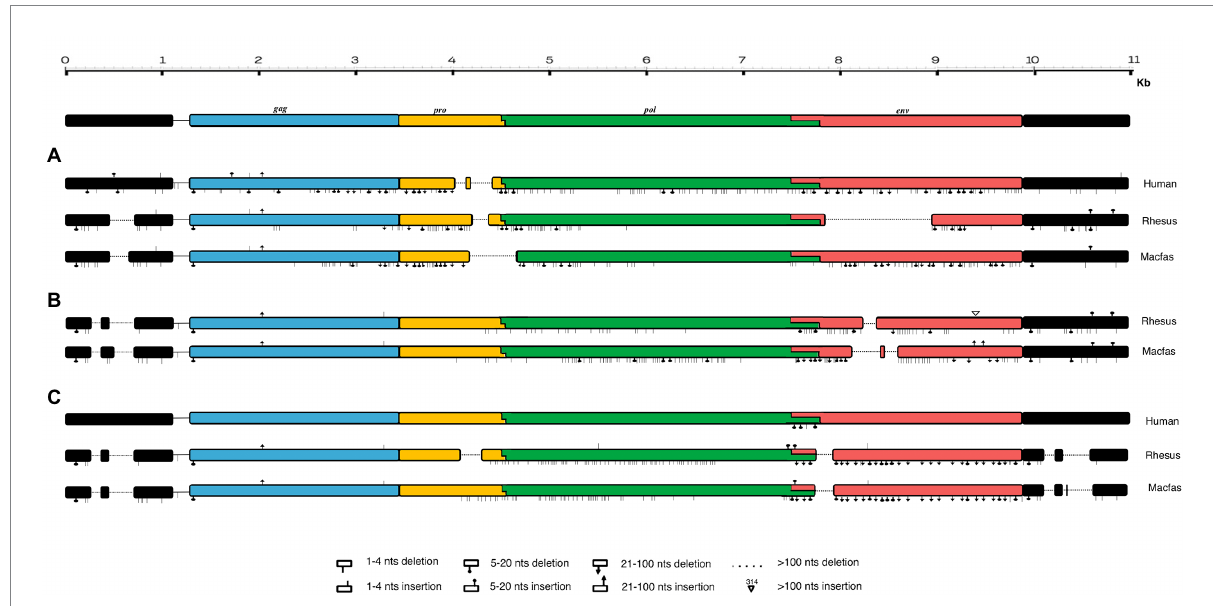
FIGURE 4 Schematic representation of HML2 proviruses in Human and Macaque genomes. Representative Consensus of HML2 proviruses (A) Shared between human and macaques. (B) Macaque-shared HML2 sequences. (C) Species-Specific